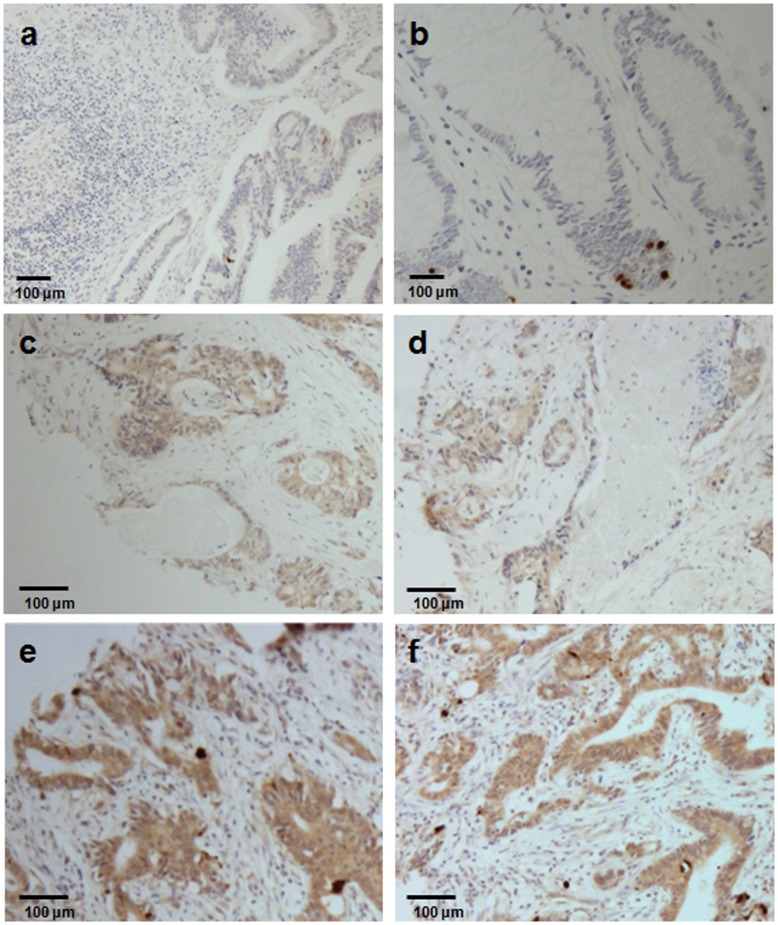
The expression pattern of ATG10 in colorectal cancer.The ATG10 expression pattern in colorectal cancer was determined by immunohistochemical analysis of a tissue microarray. (a and b) Negative specimens (−) with ≤10% staining (200), (c and d) specimens with 10% to 50% staining (+, ×200), and (e and f) specimens with >50% staining (+, ×200).